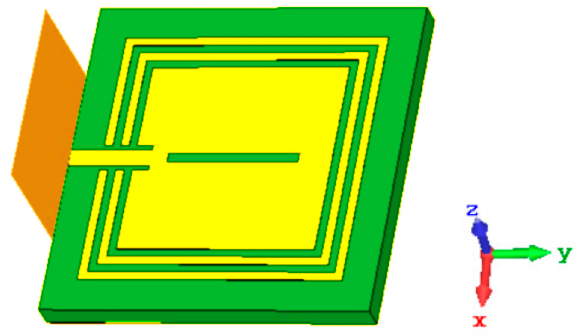
Figure 5. Single-port-feed-microstrip-based sensor.